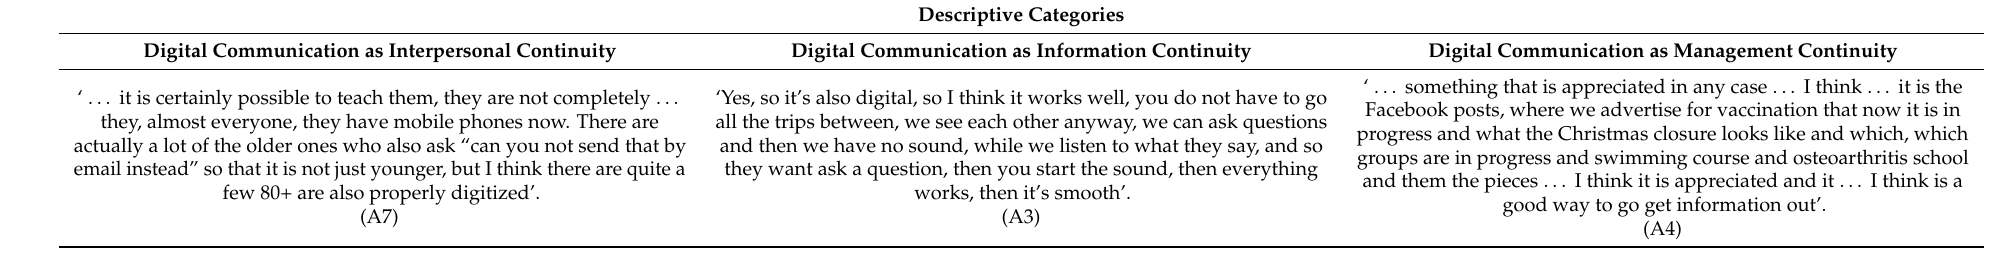
Table 2. Summary of the deductive analysis process departing from the matrix’s dimensions.